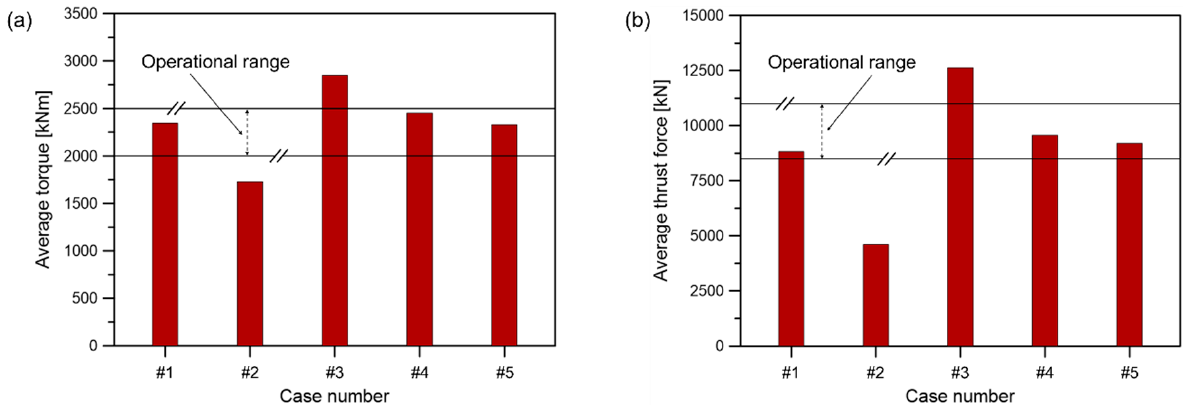
Figure 11. Comparison of average torque and thrust force during advance of the EPB shield after its first 100 mm advance: ( a ) average torque; ( b ) average thrust force.